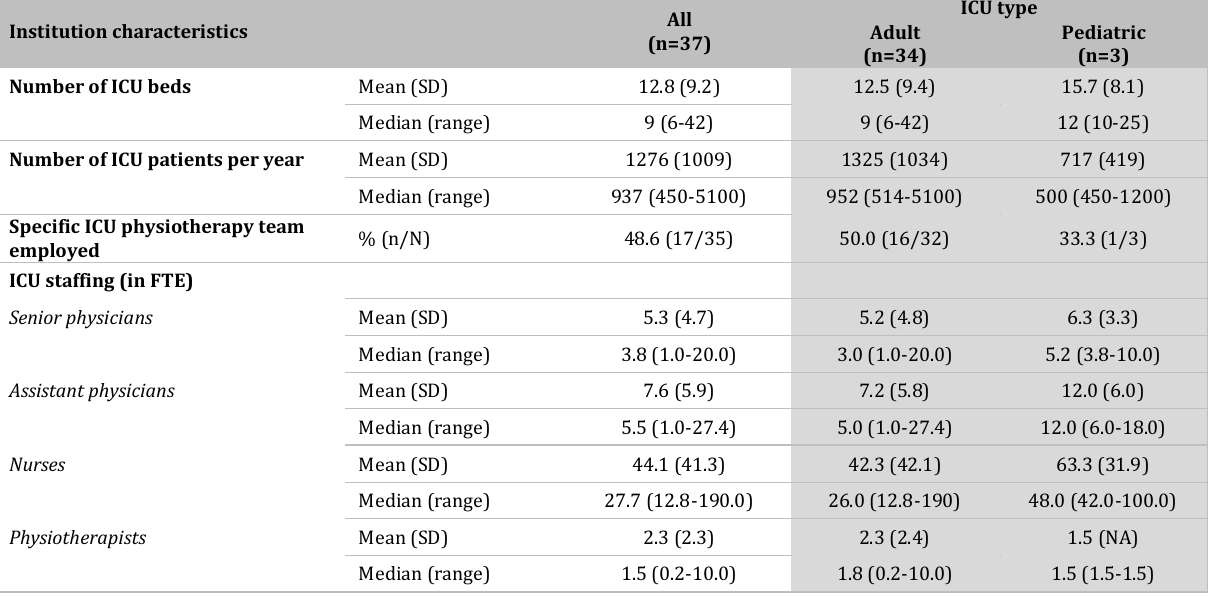
Table S2. Characteristics of participating intensive care units (by ICU type) Institution